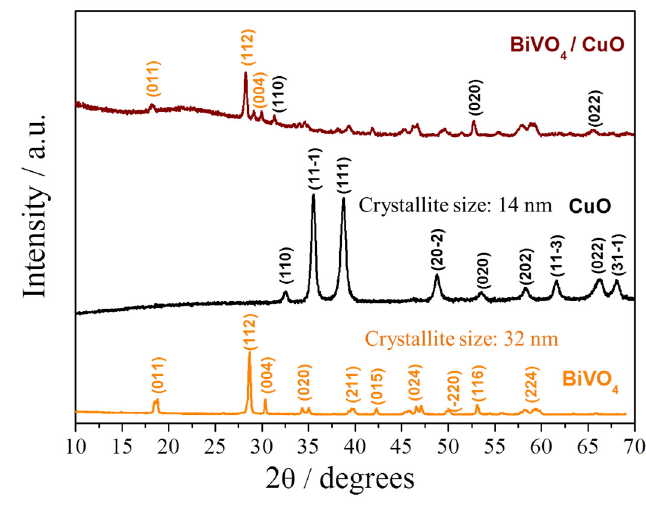
/ 4 , CuO, and BiVO 4